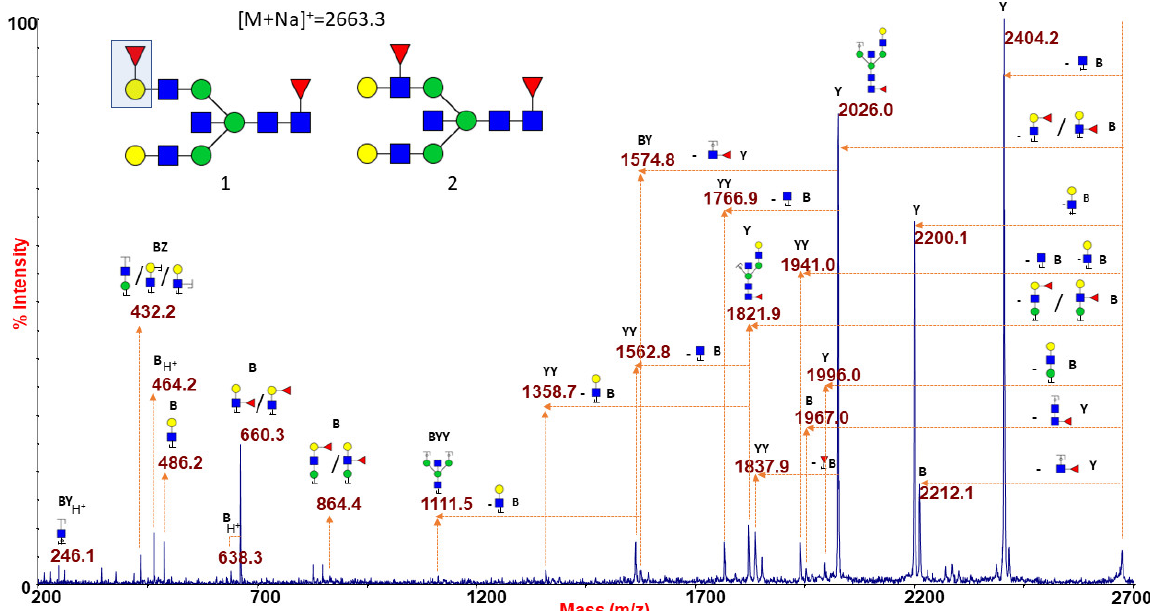
Figure 4. MALDI TOF/TOF MS/MS characterization of the N-glycan precursor at m/z 2663.3 from blood group O human erythrocytes. The reported spectrum shows the occurrence of two distinct isomers differing in the position of the antennary fucose. Fragments at m/z 660.3 and 864.4 (B ions) and at m/z 2026.0 and 1821.9 (Y ions) indicated that this monosaccharide may be linked either to a terminal Gal, giving rise to a blood group H antigen (as sketched in structure 1), or to an antennary GlcNAc, thus originating a Lewis epitope (structure 2). GlcNAc, blue square; Man, green circle; Gal, yellow circle; NeuAc, purple lozenge; Fuc, red triangle.